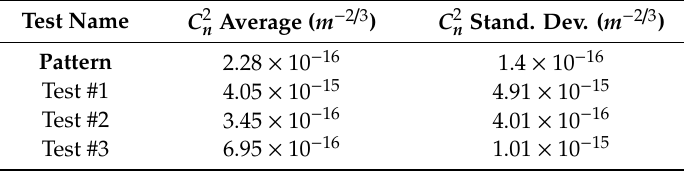
Table 5. Statistics of parameters to calculate C 2 n